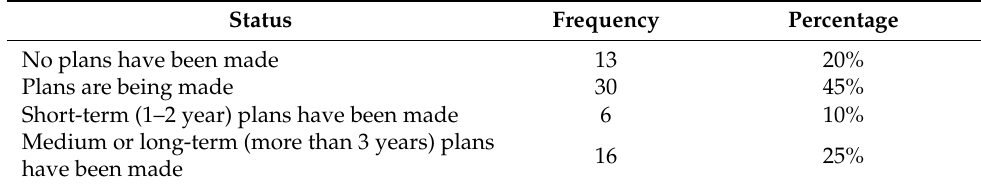
Table 5. The status of enterprises’ digital